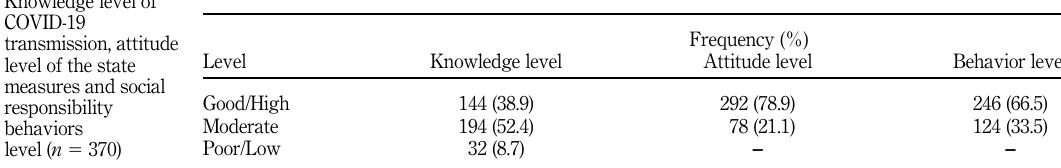
Table 4. Social responsibility behavior among university students